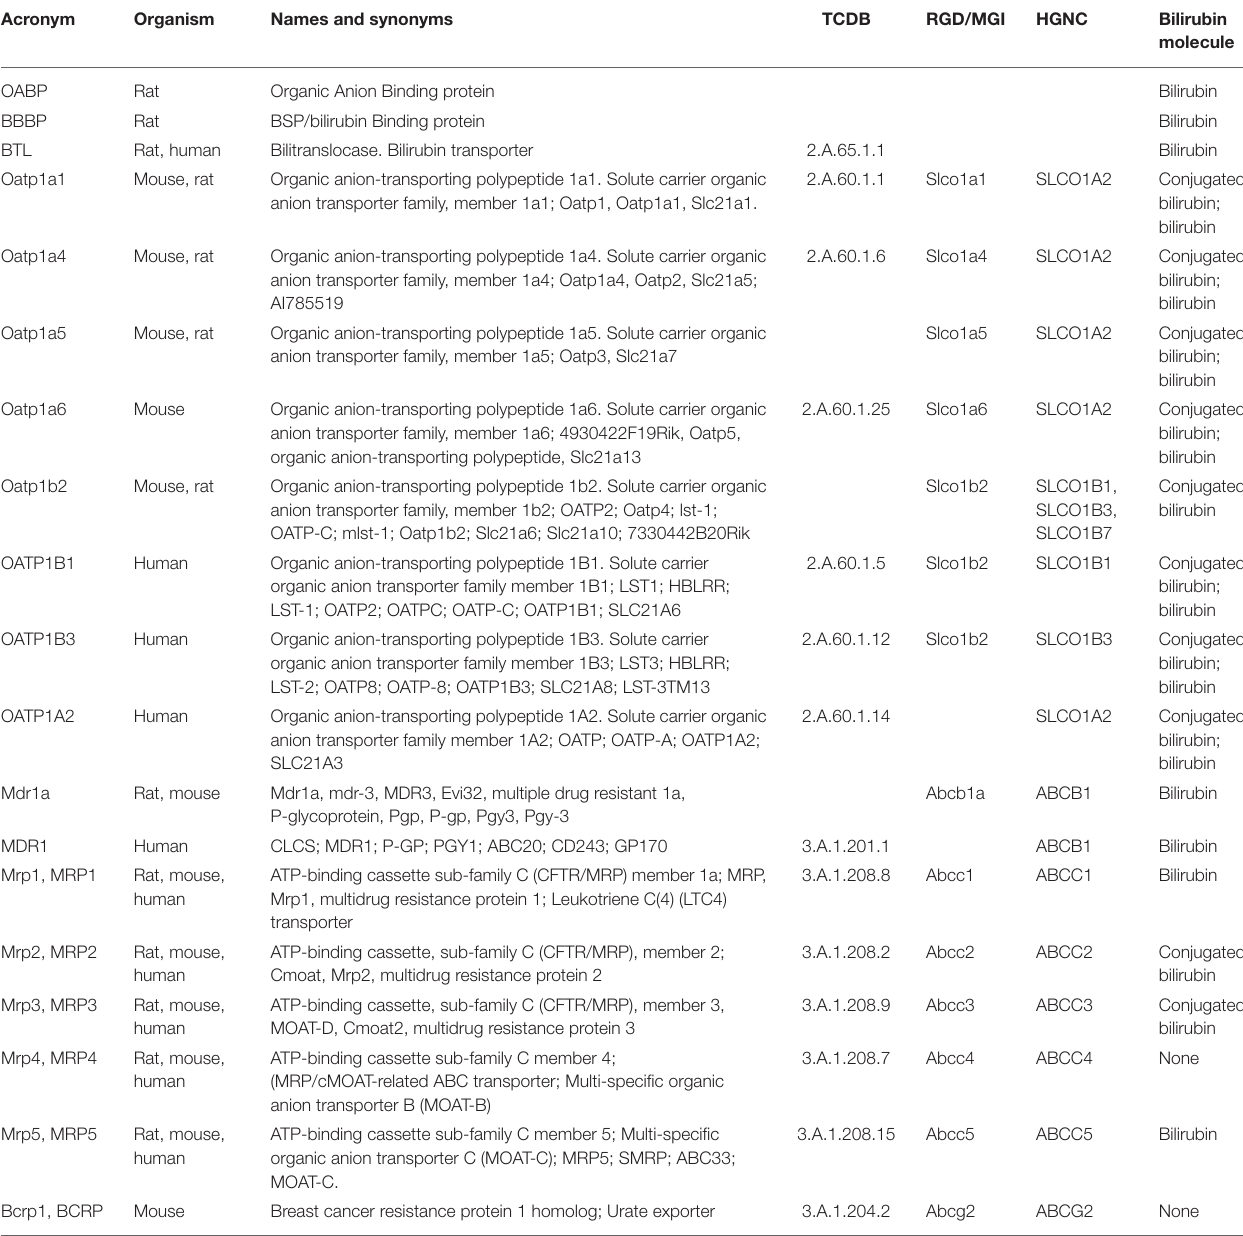
TABLE 6 | Membrane transporters of bilirubin and its conjugates.